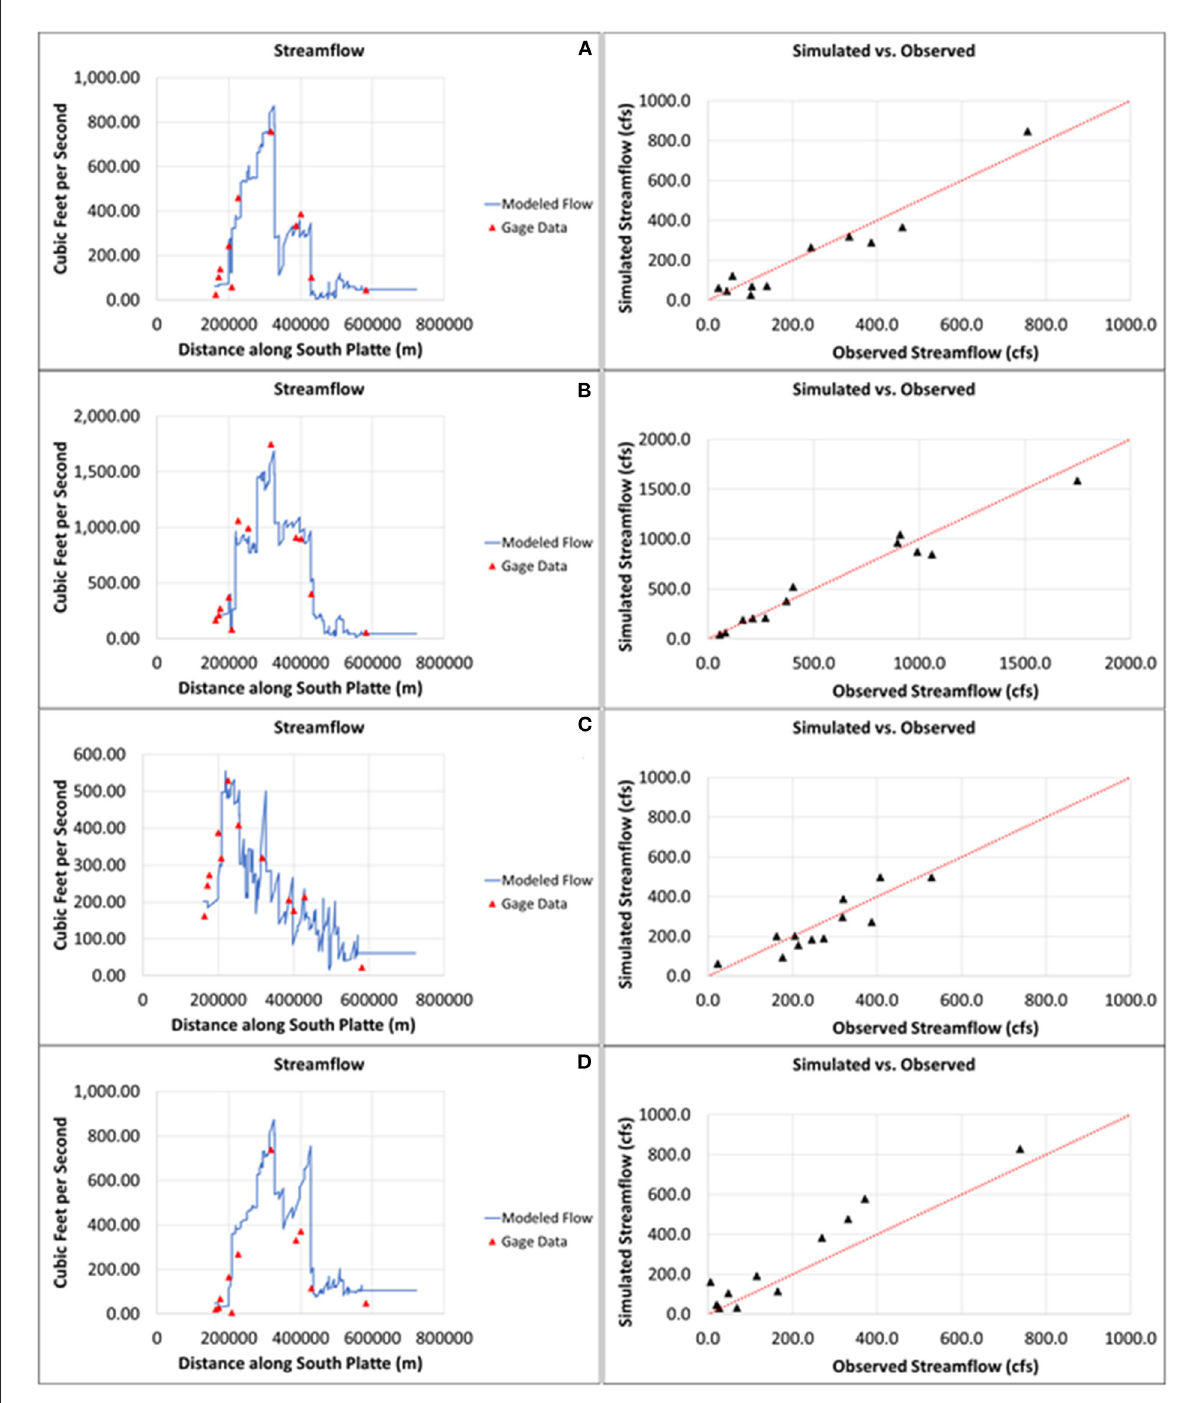
not exhibit the same rises and falls of flow (see Figure 6), as loads and concentrations increase almost linearly downstream due to return flow of saline water into the river. Note